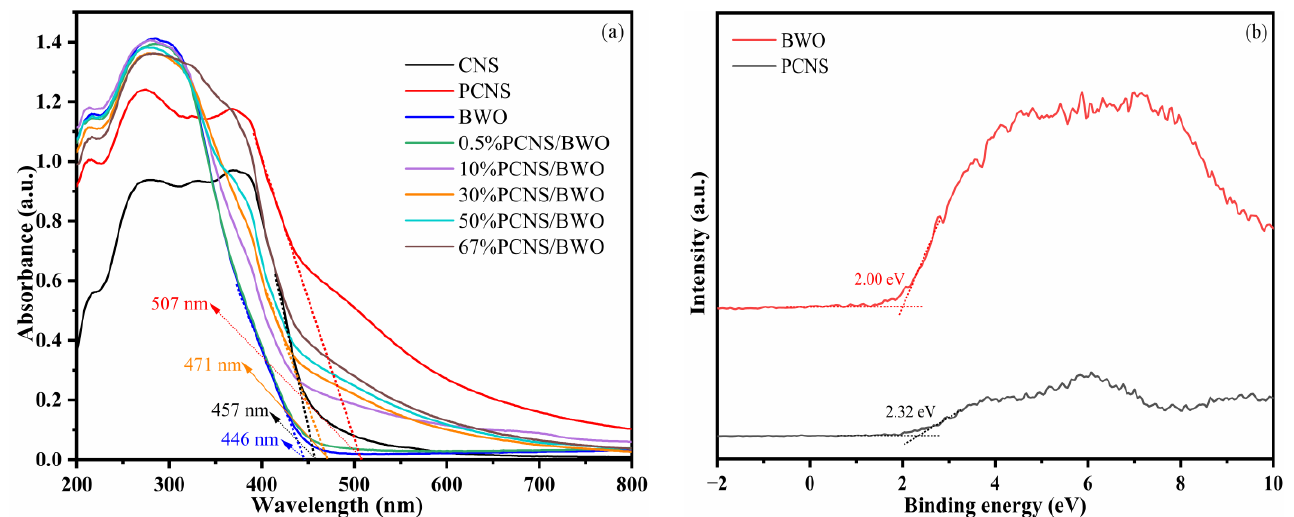
Figure 7. ( a ) UV-vis DRS spectra and ( b ) XPS-VB spectra of the